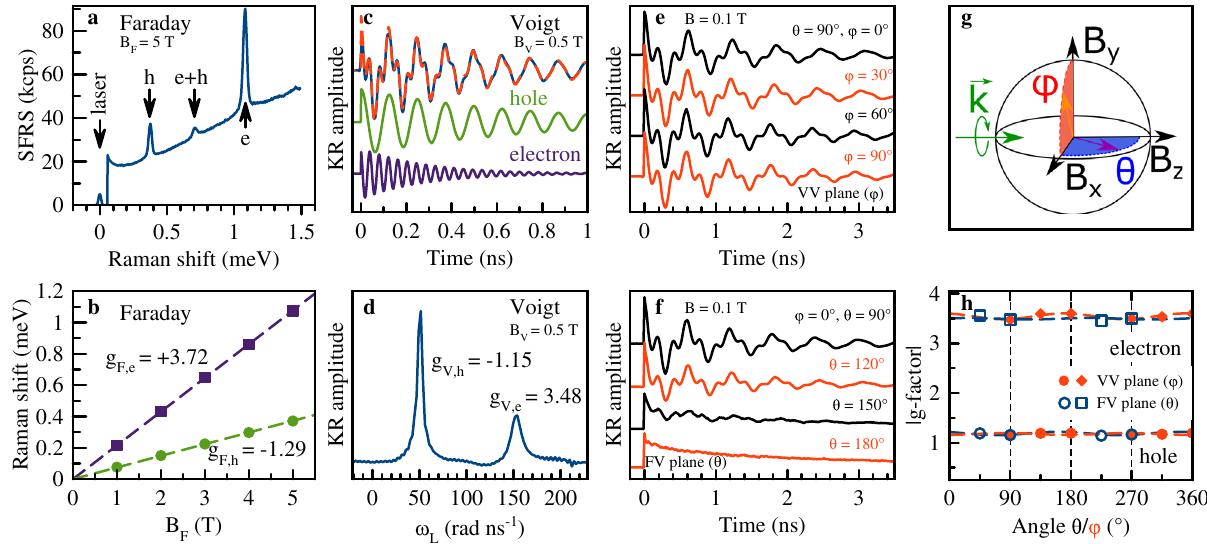
Fig. 2 Pump-probe Kerr rotation and spin- fl ip Raman scattering of FA 0.9 Cs 0.1 PbI 2.8 Br 0.2 . a SFRS spectrum in Faraday geometry ( θ = 0 ∘ , φ = 0 ∘ ) measured at T = 1.6 K. The excitation/detection polarization is σ + / σ − . b Magnetic fi eld dependencies of the measured Raman shifts (symbols). Lines are linear fi ts. c TRKR signal (blue line) measured in the Voigt geometry ( θ = 90 ∘ , φ = 0 ∘ ). Red dashed line is fi t with two oscillatory functions (see Methods) ð B ¼ 0 : 5T Þ ¼ 275 ps, T (cid:2) ð B ¼ 0 : 5T Þ ¼ 690 ps, g = − 1.15 and g = + 3.48. Decomposed electron and hole with the parameters: S e / S h = 0.8, T (cid:2) h e 2 ; e 2 ; h components are given below. TRKR data are measured at T = 5 K. d Fast Fourier transform spectrum of the signal from c . e , f TRKR signals in magnetic fi elds of 0.1 T rotated in the Voigt-Voigt and Faraday-Voigt planes, respectively. g Laboratory coordinate system: blue horizontal (red vertical) plane is the Faraday-Voigt (Voigt-Voigt) plane. h Angular dependences of the electron and hole g -factors for the magnetic fi eld rotated in the Faraday-Voigt (open symbols) and Voigt-Voigt (closed symbols) planes. Note that while g h < 0 we show ∣ g h ∣ . Lines are guides to the eye. The indices V and F indicate the Voigt and Faraday directions of the magnetic fi